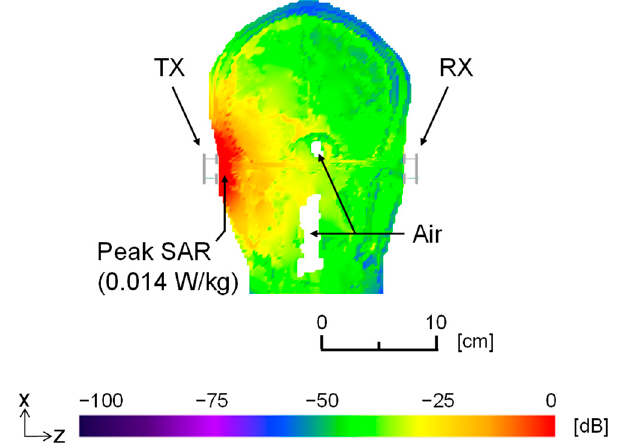
Figure 9. Specific absorption rate (SAR) distributions inside the head model with the impedance ‐ matched two ‐ electrode transceiver at 10 MHz.